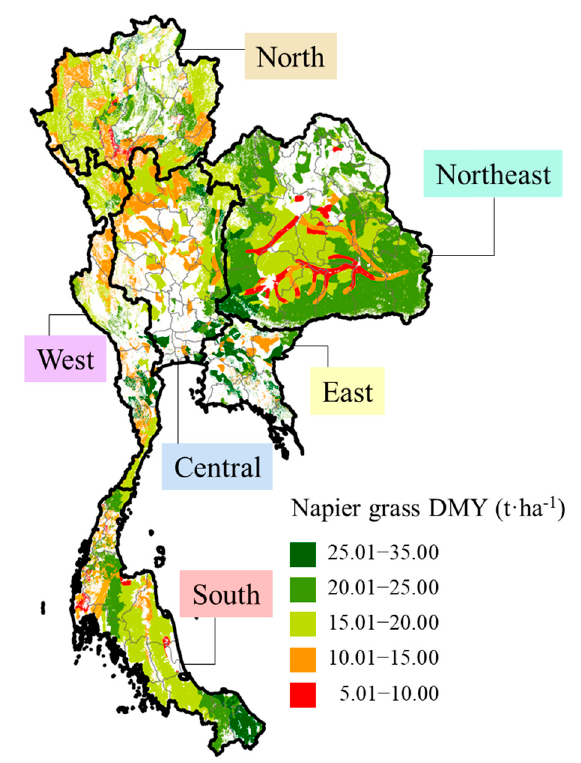
Figure 5. Spatial distribution of simulated mean yield per hectare of Napier grass in Thailand.